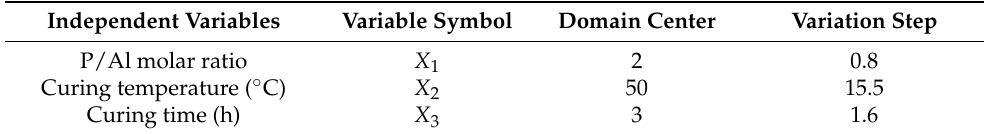
Table 4. Experimental range and level of independent variables.